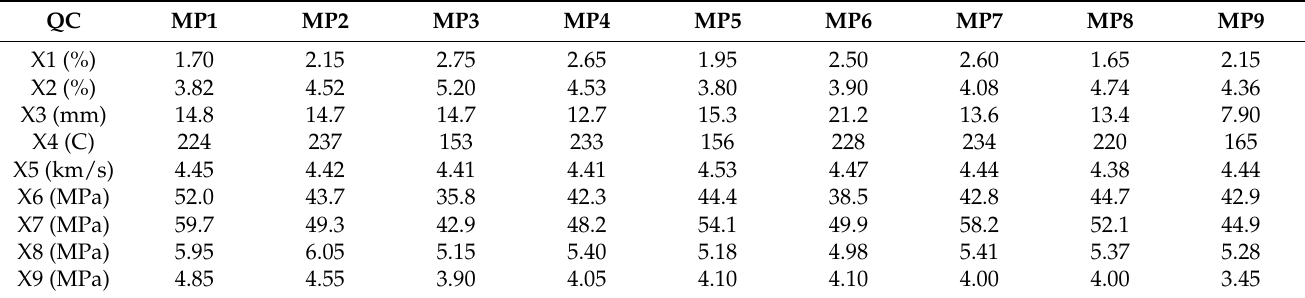
Table 7. Experimental responses of MPFA concrete.